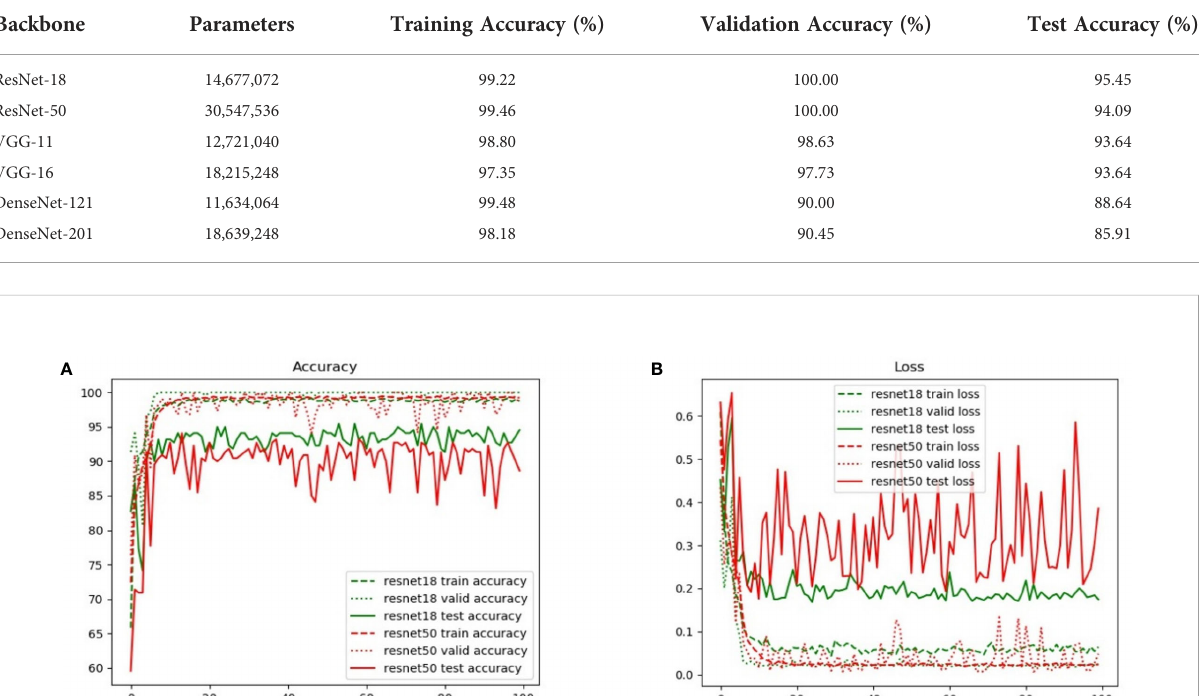
TABLE 2 Correlation between model size and training accuracy.